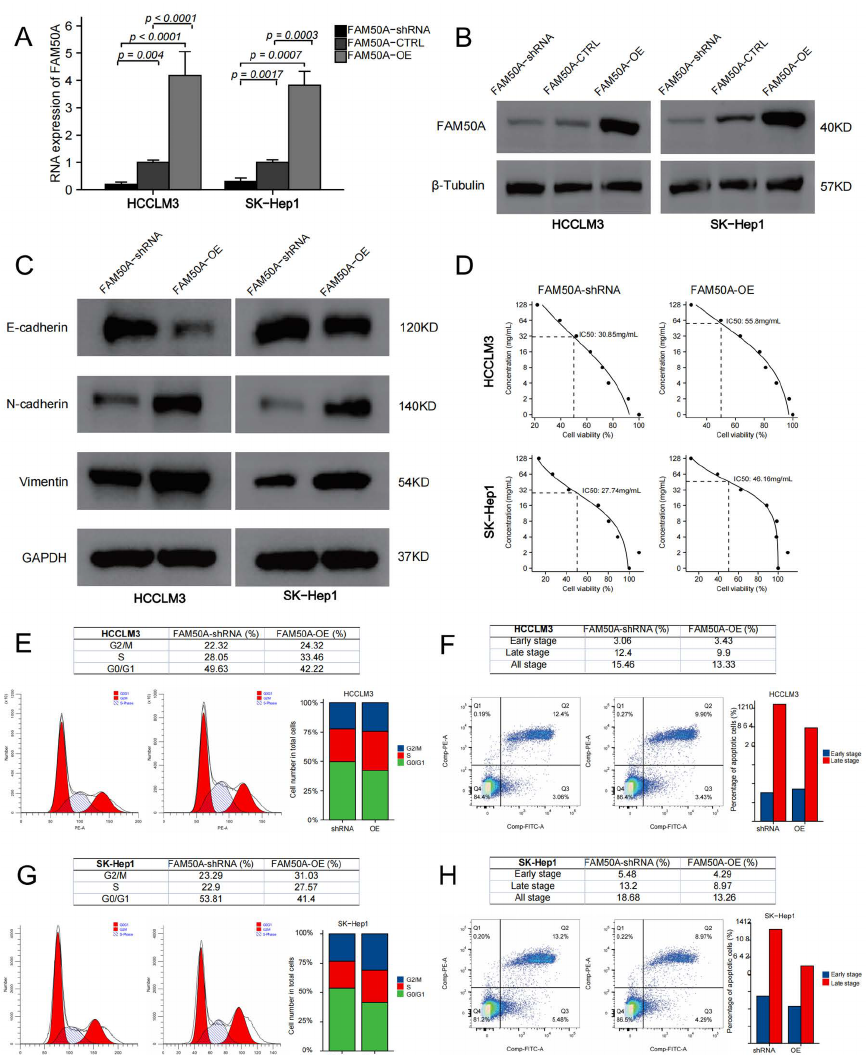
Figure 5. Effects of FAM50A on the function of HCC cells. We knocked down and overex- pressed FAM50A expression in HCCLM3 and SK-Hep1 cells to explore the efficacy of FAM50A on EMT, drug susceptibility, cell cycle and apoptosis of HCC cells. ( A ) The mRNA expression of FAM50A detected by qRT-PCR. ( B ) The protein expression of FAM50A detected by Western blot and β -tubulin was used as the internal reference. ( C ) The protein expression of E-cadherin, N- cadherin and vimentin detected by Western blot and GAPDH was used as the internal reference. ( D ) IC 50 of different cells: FAM50A-shRNA-treated HCCLM3 cells (30.85 mg/mL),